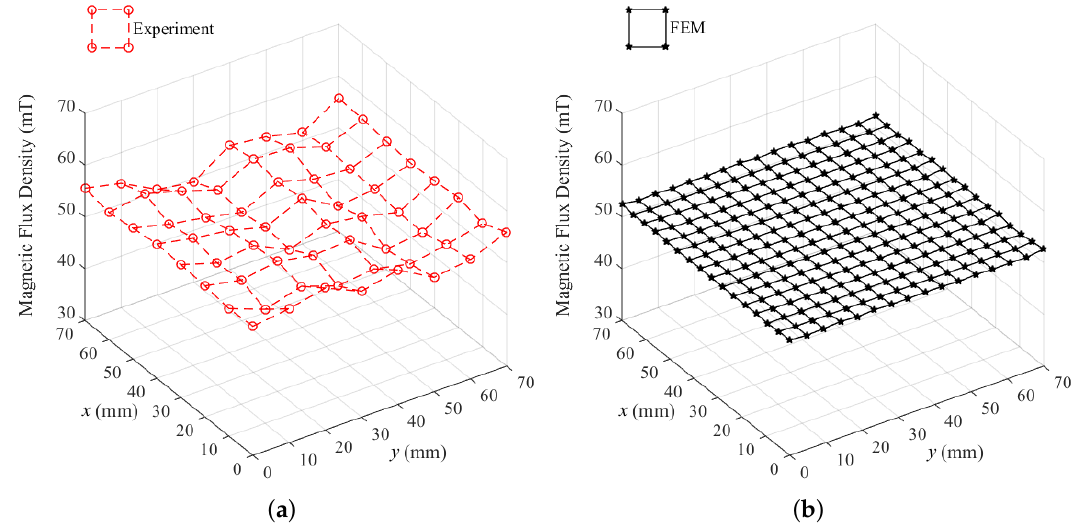
Figure 8. The ( a ) experimental; and ( b ) FEM distribution of the magnetic flux density as the gap distance is l g = 2.5